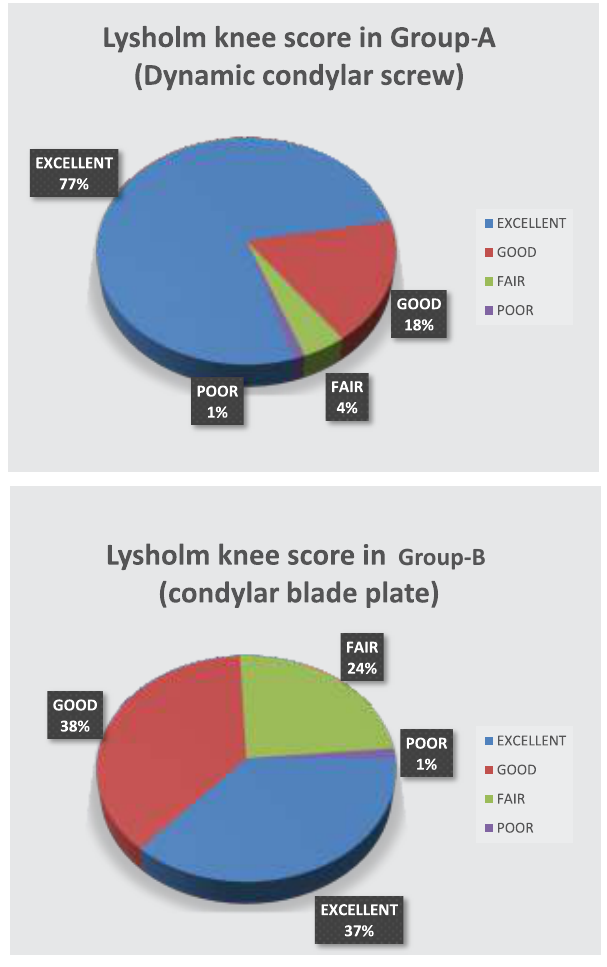
Figure-II: Functional outcome in patients with condylar blade